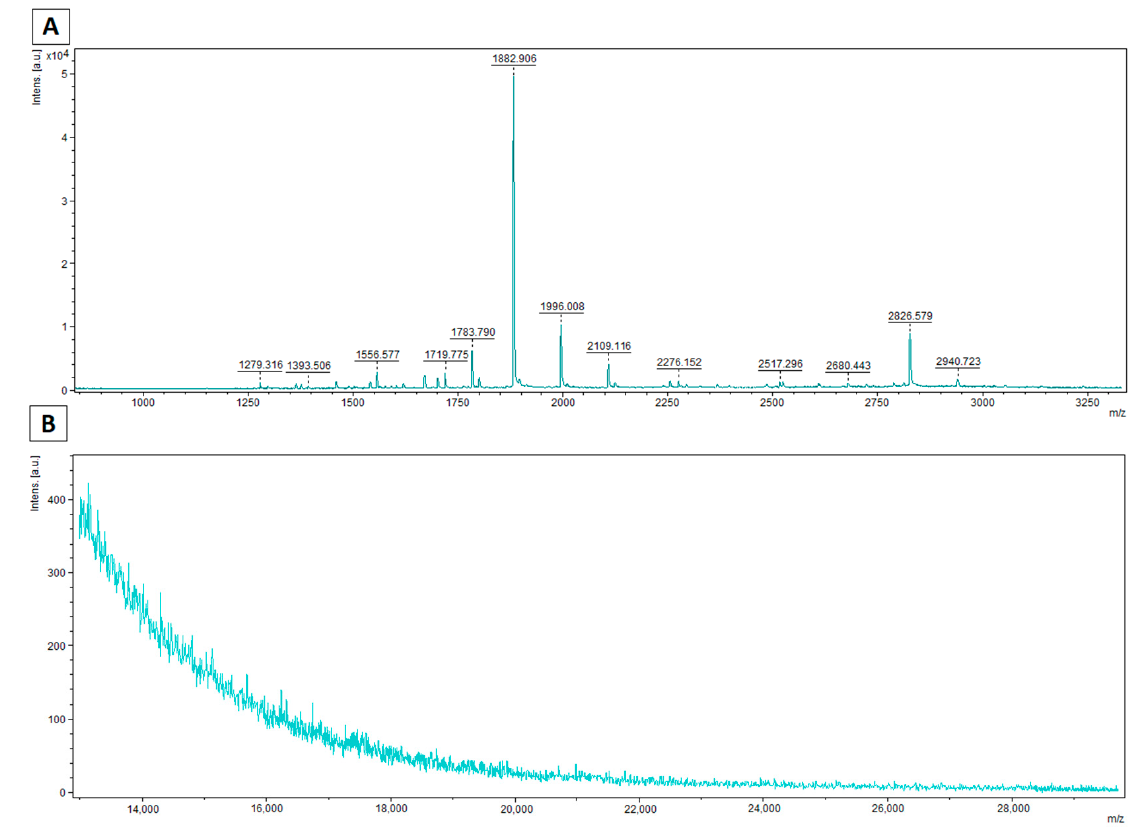
Figure 5. Spectra acquired for casein treated with curly kale extract for 24 h ( A ) for low molecular masses (0.7–5 kDa) using the HCCA matrix; ( B ) for molecular masses in the casein range (13–30 kDa) using the HCCA+DHB matrix.